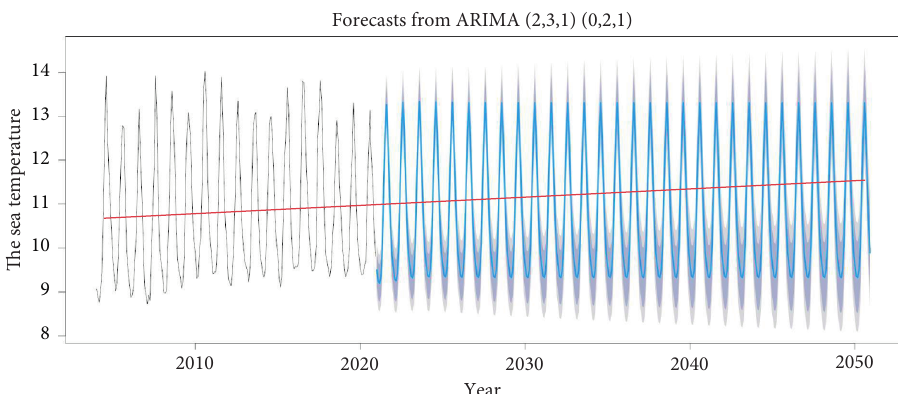
Figure 13: Time series forecast of monthly average sea temperature in region